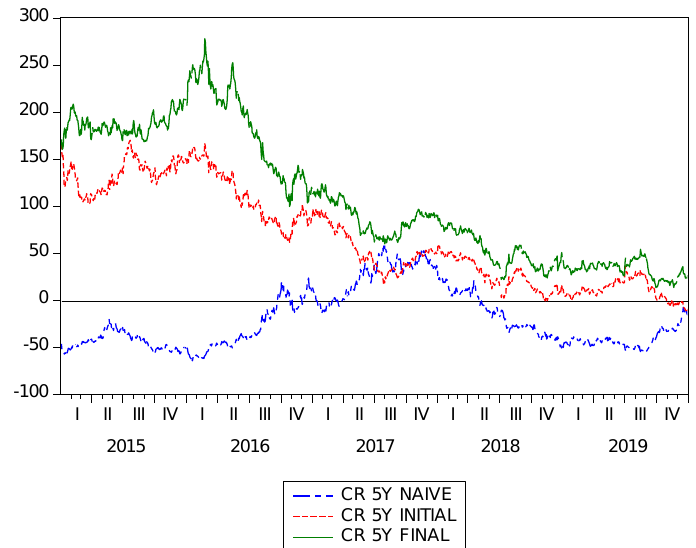
Figure 3. Cumulative returns of strategies (5-year rolling window). This figure displays the 5-year rolling window cumulative returns over the out-of-sample period for the naïve strategy, the best strategy using logarithm returns, labeled as initial, and the best one using standardized returns, labeled as final.